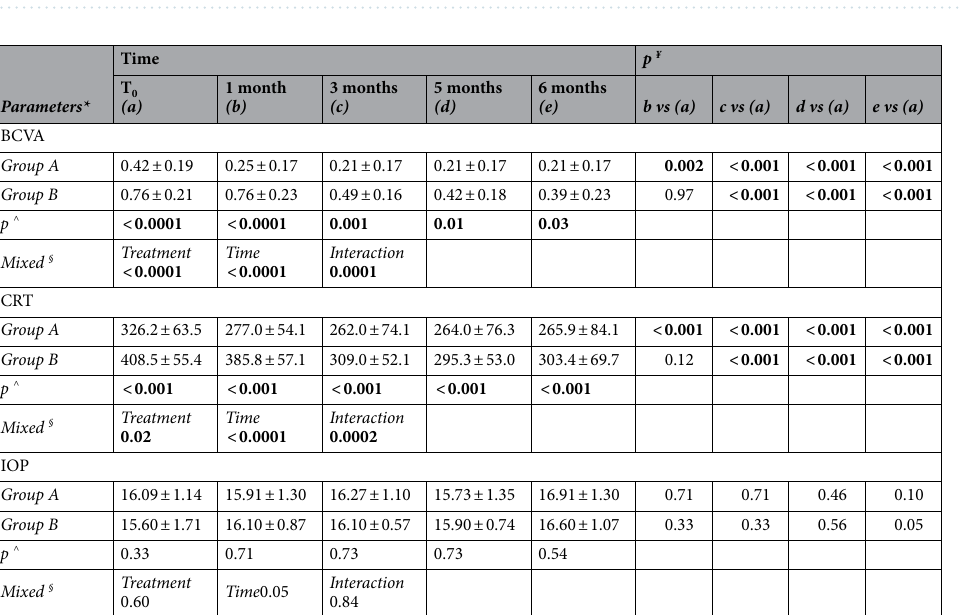
Figure 2. Mean Best corrected visual acuity (BCVA) in Groups ( A and B ) over the study follow-up. DEX-i, intravitreal dexamethasone implant; ERM/ILM, Epiretinal Membrane/Inner Limiting Membrane; * P < 0.01 as compared to T 0 within each group.